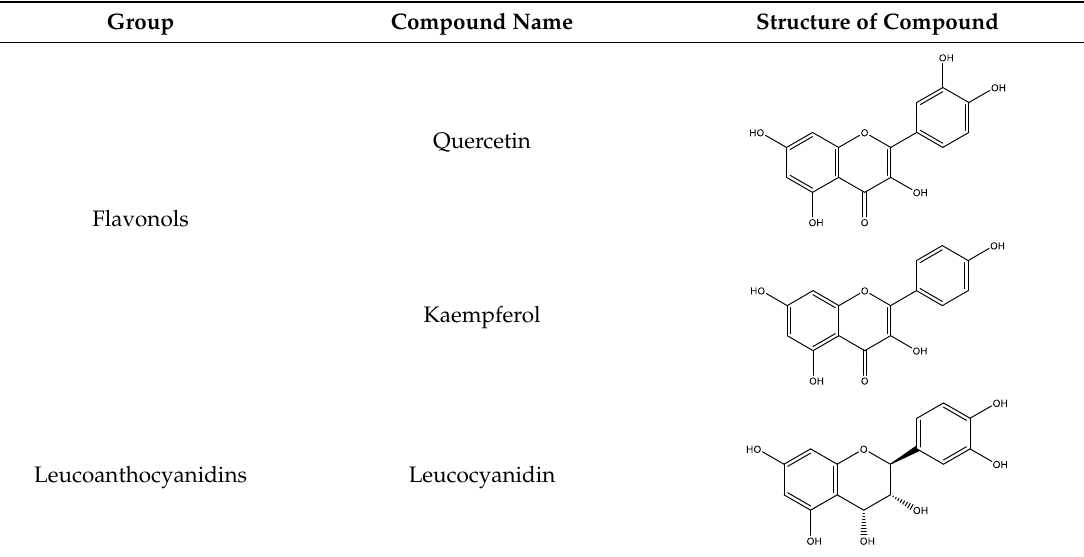
Table 5. Some major isolated phytoconstituents on Euphorbia hirta L.